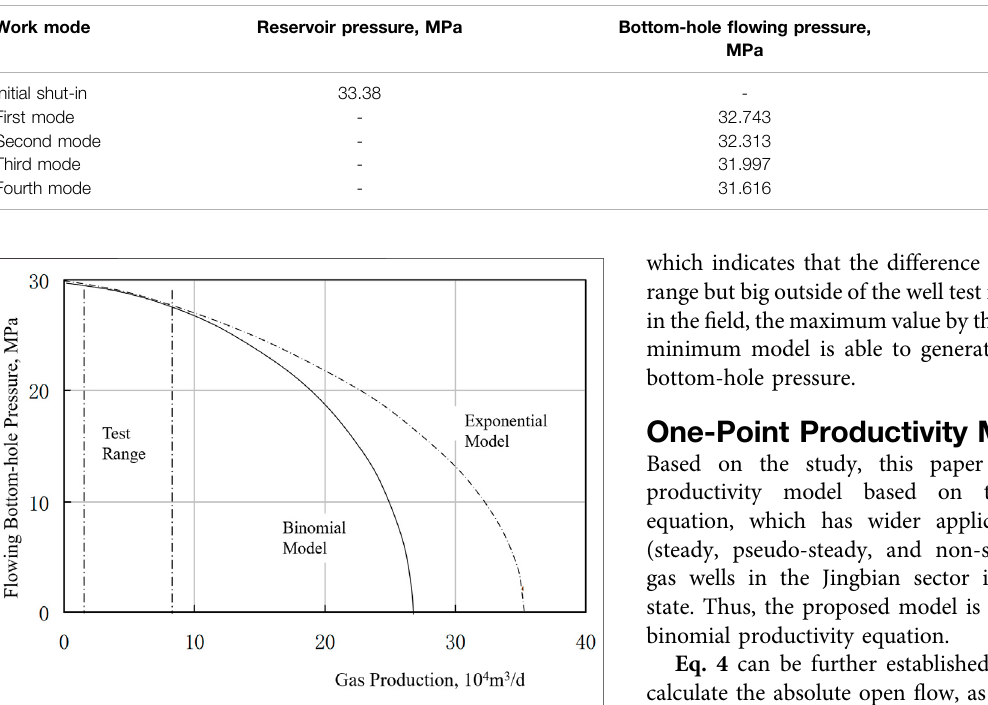
TABLE 2 | Correction of isochronal well test data table of well Jing 32-1.